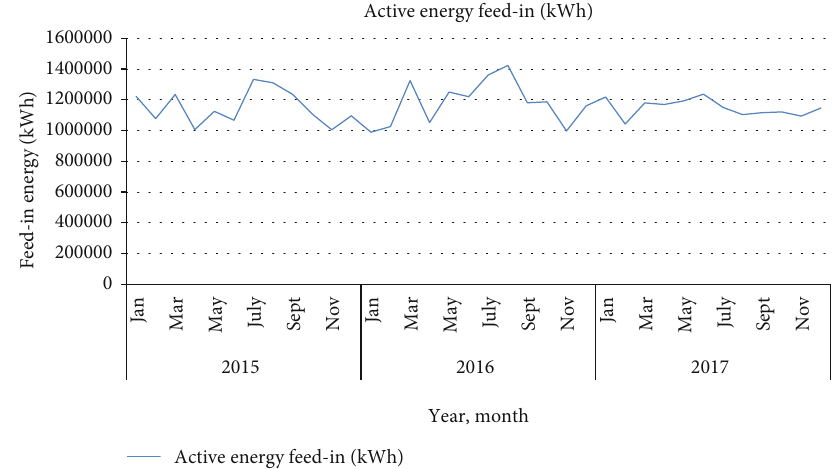
Figure 2: Energy feed-in in the national power grid by the Rwamagana gigawatt solar power plant (2015-2017).